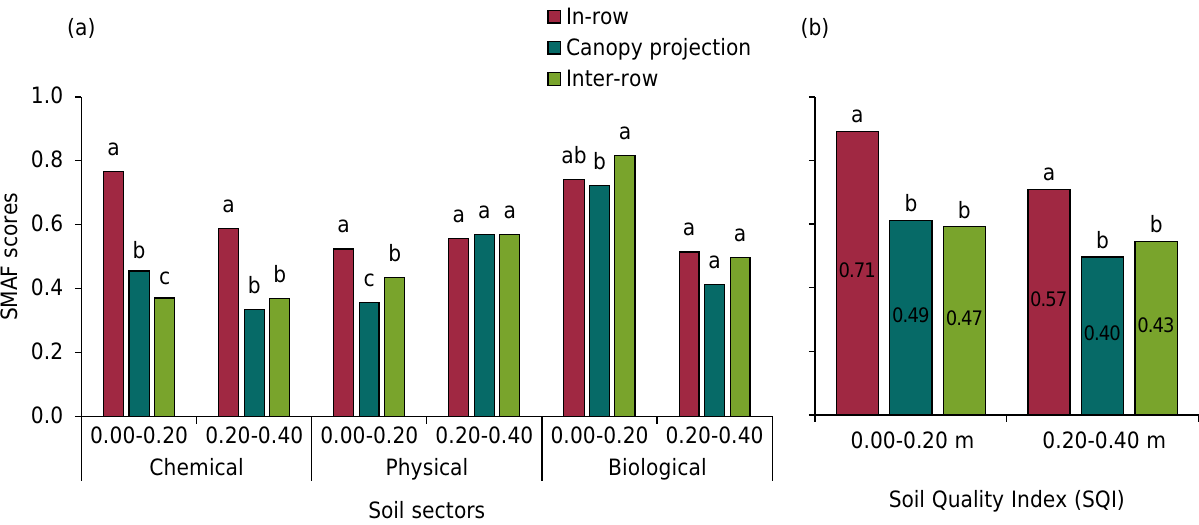
Figure 1. Soil sectors (chemical, physical, and biological) (a) and overall Soil Quality Index (SQI) (b) for the 0.00-0.20 and 0.20-0.40 m layers in the row, canopy projection and inter-row within an orange orchard. Mean scores within each depth and sector or SQI followed by the same letter do not differ among themselves according to Tukey’s test (p<0.05).